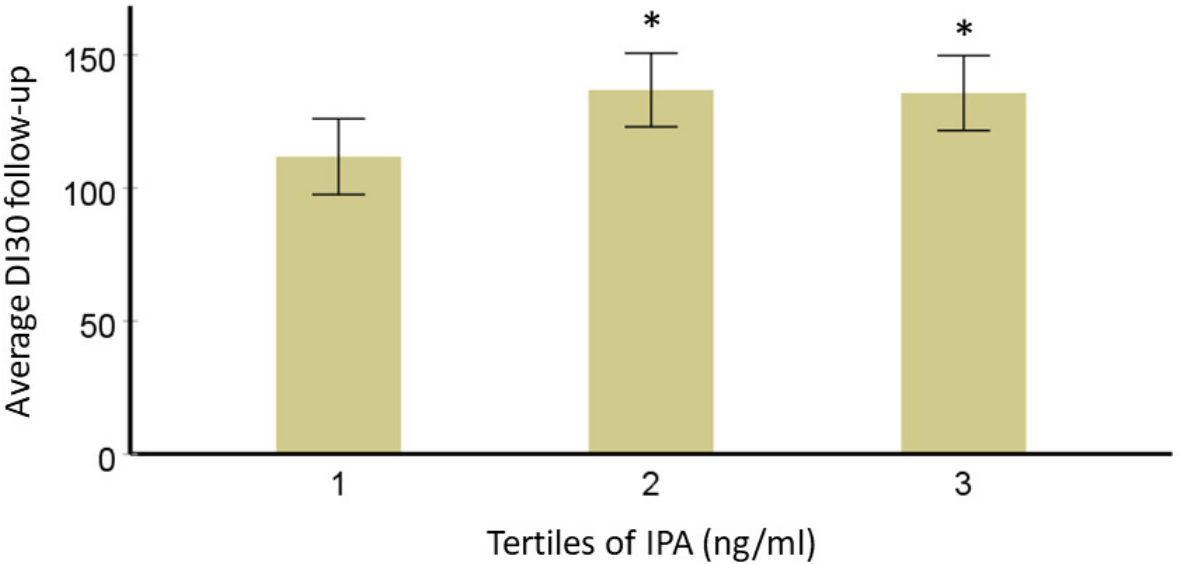
Figure 3. Averaged disposition index during the 7-year follow-up ( y -axis) by tertiles (1st n = 31, 2nd n = 32, 3rd n = 31) for serum IPA concentration ( x -axis, models adjusted for age, sex, BMI, and study group) in the DPS. * Represents p -value < 0.05 vs. 3rd one for IPA. The bars represent the estimated marginal means with confidence intervals (95%).